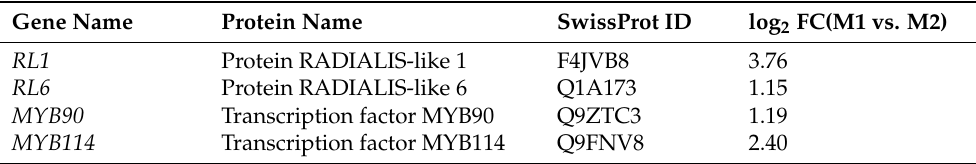
Table 4. Differentially expressed transcription factor (TF) involved in flavonoid biosynthesis and their RPKM values in M1 vs.